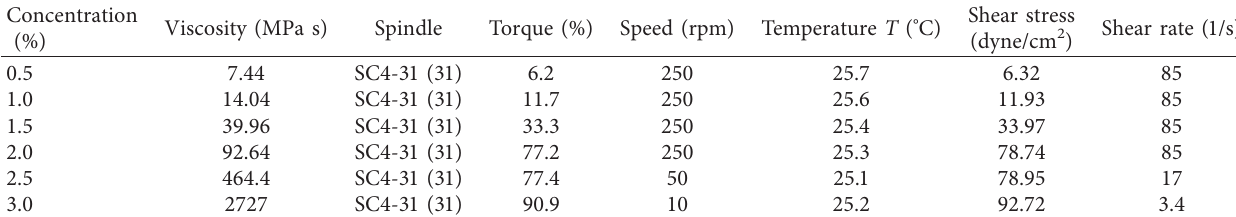
Table 1: Nanoparticle (KY-200) viscosity